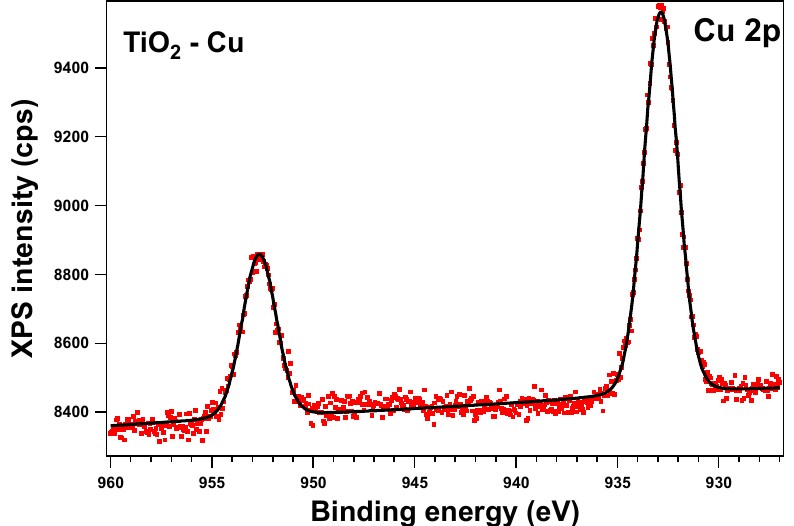
Figure 4. XPS spectra of the core level Cu 2p of the as-prepared Cu-doped sample: red symbols for the experimental data and black line for the one-component fi t.